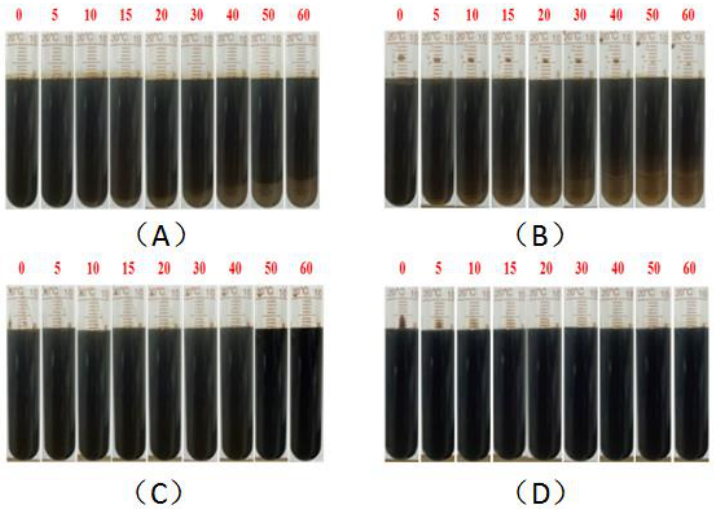
Figure 10. The evaluation of emulsion stability by dynamic light scattering: Binary flooding system with KPS ( A ) and BSB ( B ) as surfactant.